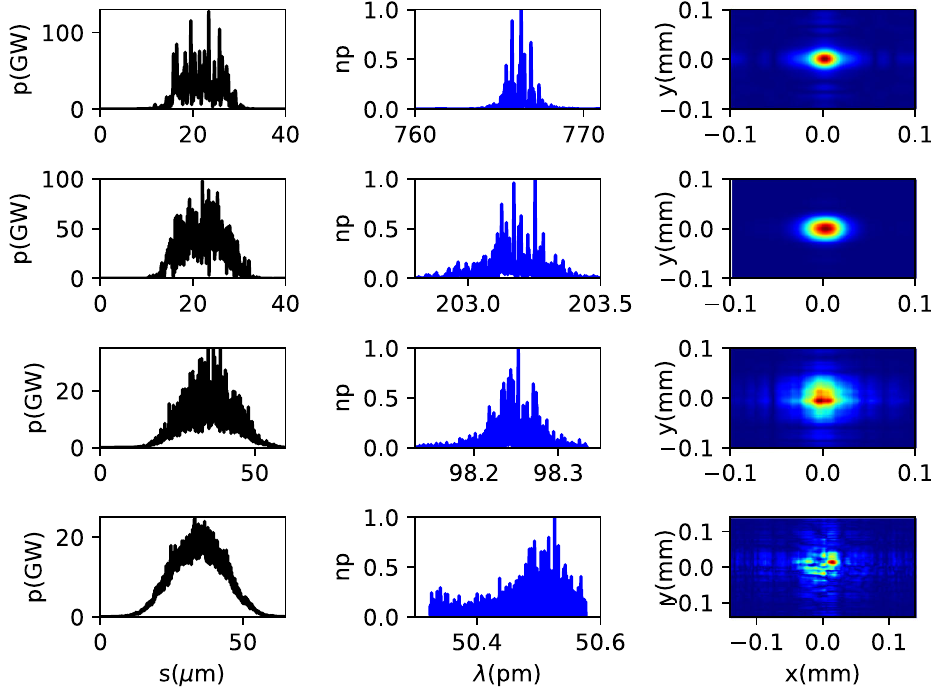
FIG. 6. Spatial profile of the radiation pulse (left), wavelength spectrum of the radiation (center), where np designates the normalized power, and transverse cross section of the of FEL radiation pulse around the point of saturation (right) for a beam energy of 10, 20, 30 and 40 GeV (from top to bottom), as simulated with GENESIS , using the respective distribution of the accelerated beam, obtained from ELEGANT , as